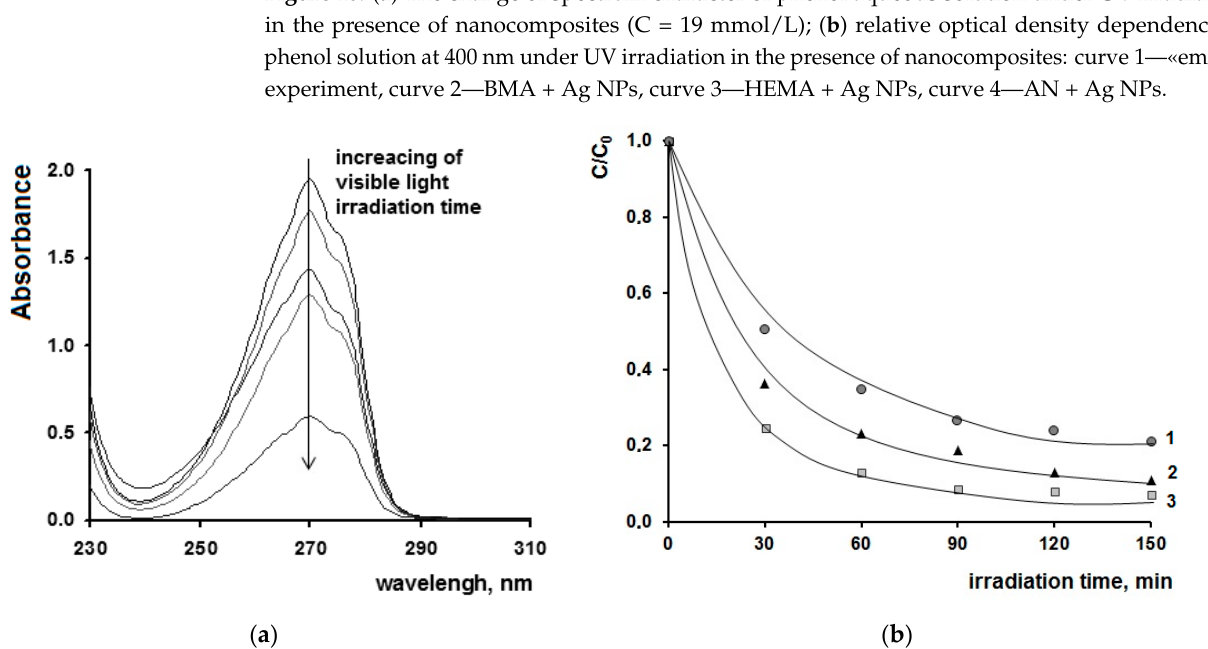
Figure 11. ( a ) The change in the nature of the aqueous solution spectrum of phenol at its irradiation with visible light in the presence of nanocomposites; ( b ) the dependence of the relative concentration of phenol in the solution under irradiation of visible light in the presence of nanocomposites of different composition: curve 1—BMA + Ag NPs, curve 2—HEMA + NPs Ag, curve 3—AN + Ag